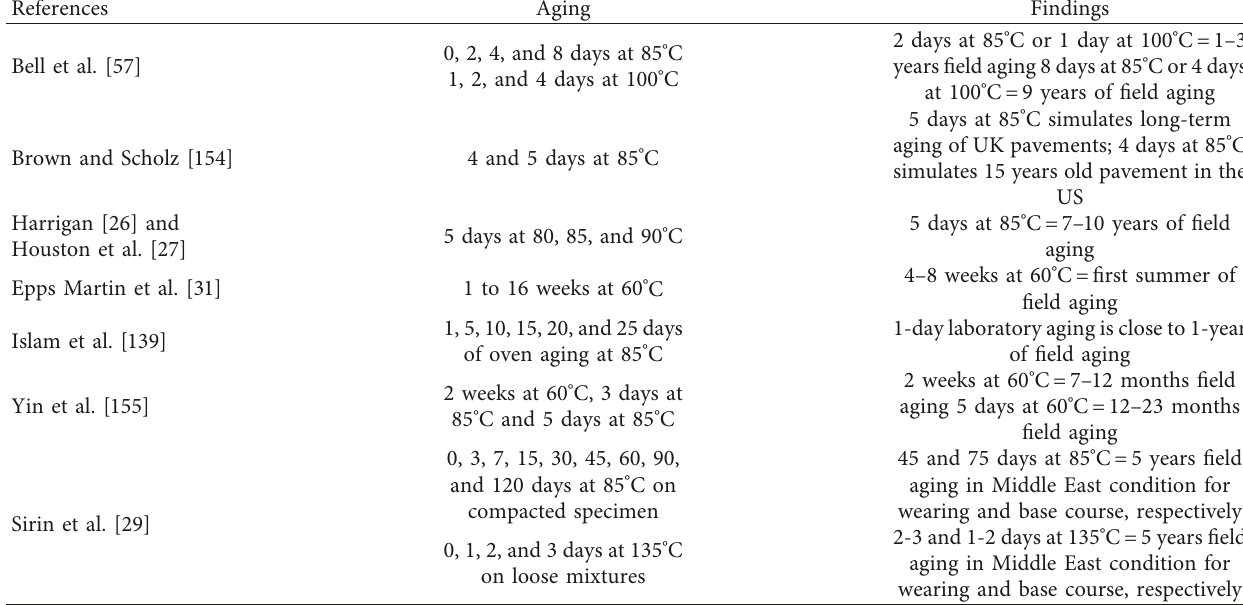
Table 4: Studies on the simulation of long-term aging of asphalt